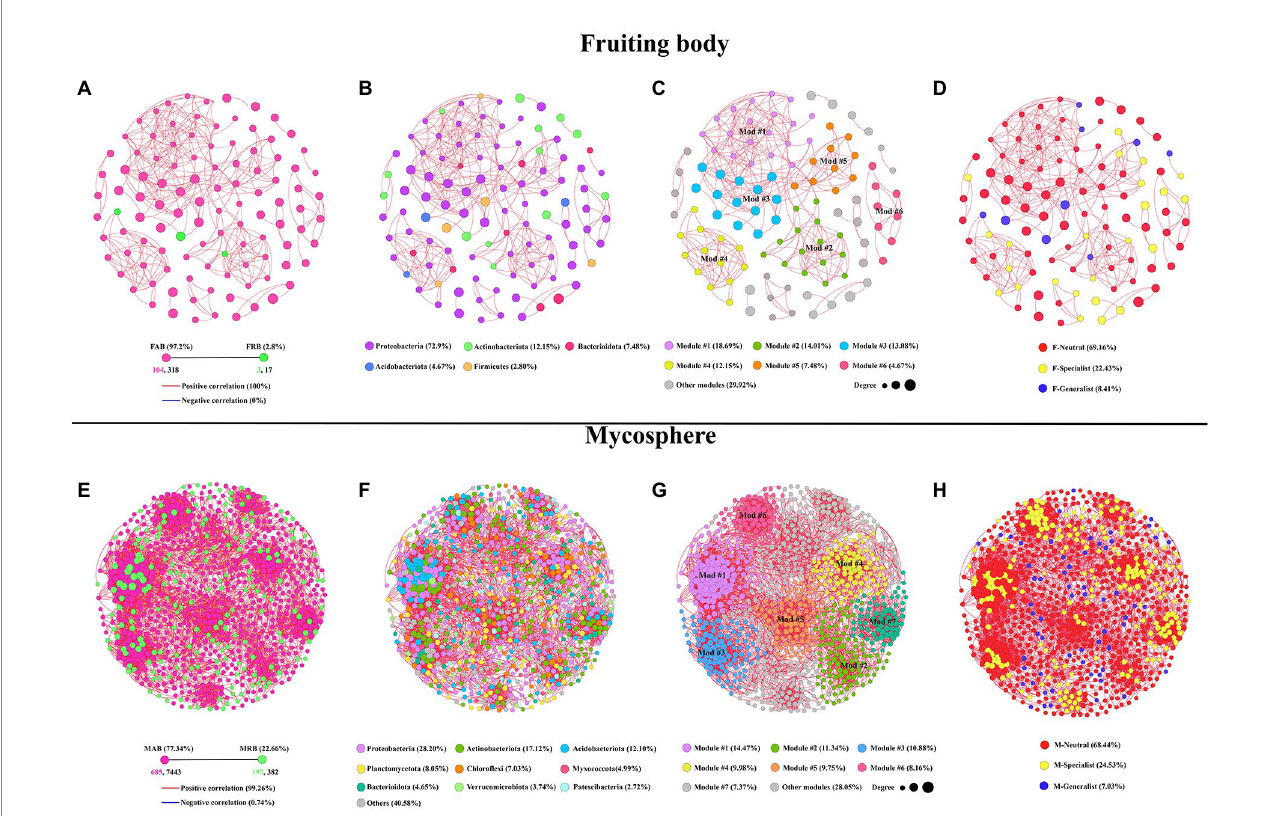
FIGURE 6 Analysis of the bacterial co-occurrence network between the fruiting body and mycosphere. (A,E) Depict the correlation co-occurrence network of abundant and rare bacteria in the fruiting body and mycosphere, respectively. (B,F) Depict the correlation co-occurrence network of bacterial taxonomic information in the fruiting body and mycosphere, respectively. (C,G) Depict the modularity of the bacterial correlation co-occurrence network of the fruiting body and microsphere, respectively. (D,H) Depict the type information of specialist, generalist, and neutral groups, respectively. Nodes of the network are colored according to abundant and rare bacteria information (A,D) , taxonomic information (B,E) , modularity (C,F) , and types of the generalist, specialist, and neutral group (D,H) . The size of the node depends on the degree of connectivity. Edge colors indicate positive (red) and negative (blue)